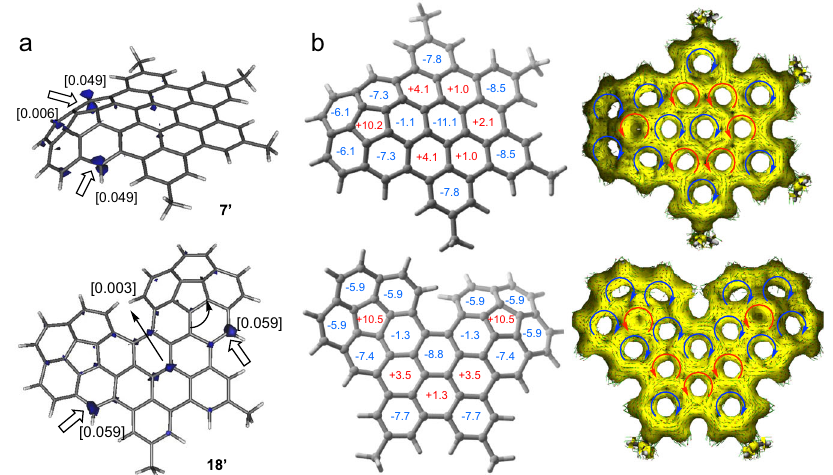
Fig. 3 | Origin of regioselectivity and aromaticity. a Plot of the Fukui ’ s suscept- ibilities (isosurface value of 0.025 au) for 7 ′ (top) and 18 ′ (bottom). Values in brackets indicate the corresponding computed Fukui functions. b AICD plots (right) computed for the nanographenes (isovalue of 0.035 au). Clockwise (blue)